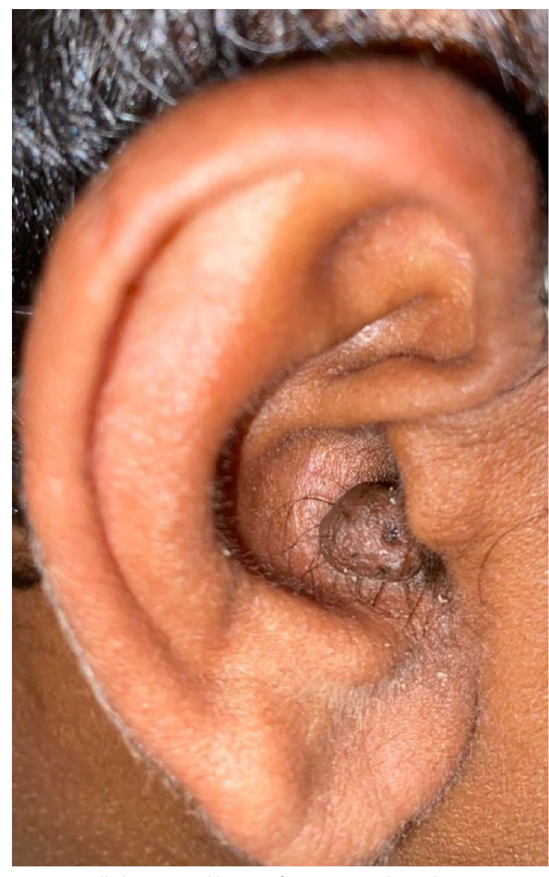
Fig. 1 A well-demarcated lesion of 1